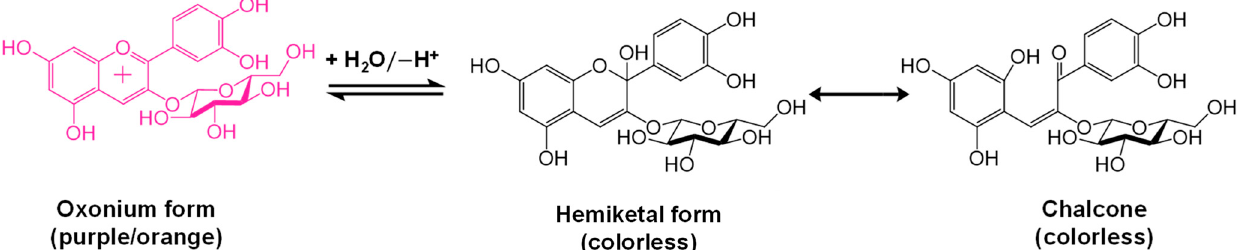
Figure 1. pH-dependent structural conversion of anthocyanin from purple-colored flavylium cation (dominant at pH 1.0) to the two resonant structures (hemiketal/chalcone) that are colorless (dominant at pH 4.5).